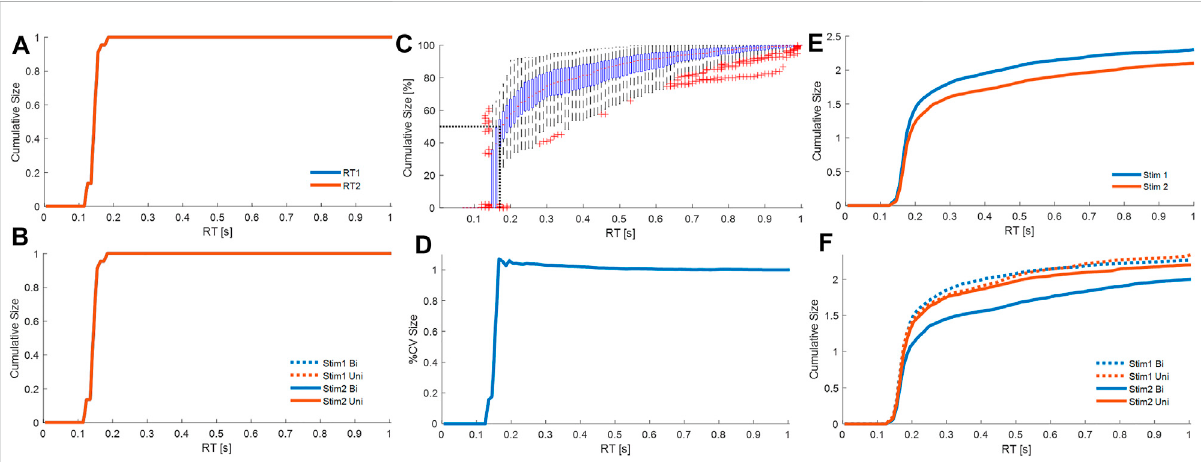
Cumulative contribution at each latency. Cumulative size of the response from all processes M1. Combining all participants, and all trials from each participant, panels show cumulative size of fi xed delay responses curves at latency (0 – 1 s). (A) : cumulative absolute size for stim1 (blue) and stim2 (red) relative to the stimulus size. (B) : cumulative absolute size for Uni (red) and Bi (blue) directional pairs; stim1 (dotted), and stim2 (solid). Cumulative size of the response from all processes M3. Combining all participants, and all trials from each participant, panels show cumulative size of fi xed delay and variable delay. (C) : cumulative size (% of trial value at 1s, all cases normalized per trial) vs. latency. Boxplots for each latency show all trials. The reddots aremedian values betweentrials.Red crosses are outliers. Horizontaland vertical dotted blacklines respectively indicate 50%totalcumulativesizeandthecorrespondinglatency(185 ms). (D) :cumulativecoef fi cientofvariation(%)vs.latency. (E) :cumulativeabsolutesize forstim1(blue)andstim2(red)relativetothestimulussize. (F) :cumulativeabsolutesizeforUni(red)andBi(blue)directionalpairs;stim1(dotted),and stim2 (solid). Panels A – B, D-F show average of all participants, where each participant is an average of all their cases. Message: Strength of response and function differ between fi xed and variable delay